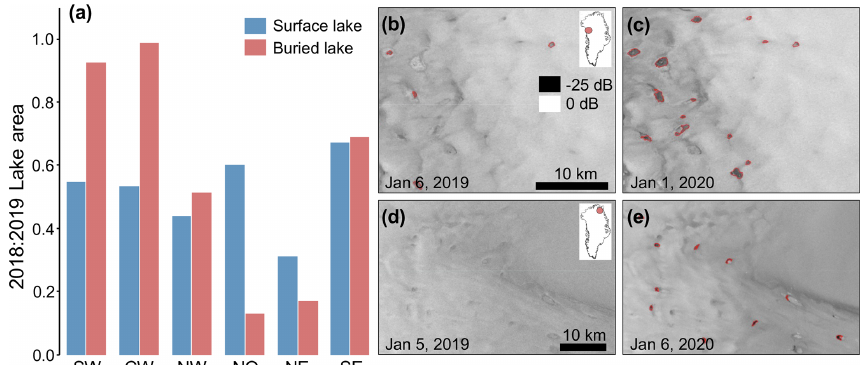
Figure 4. Comparison of 2018 and 2019 total surface and buried lake areas. (a) Ratio of 2018 to 2019 total detected surface (blue) and buried (red) lake area for each major GrIS drainage basin. (b–e) S1 images from NW Greenland (b, c) and NE Greenland (d, e) , with detected subsurface lakes outlined in red. (b) 6 January 2019 (following the 2018 melt season). (c) 1 January 2020 (following the 2019 melt season). (d) 5 January 2019. (e) 6 January 2020.